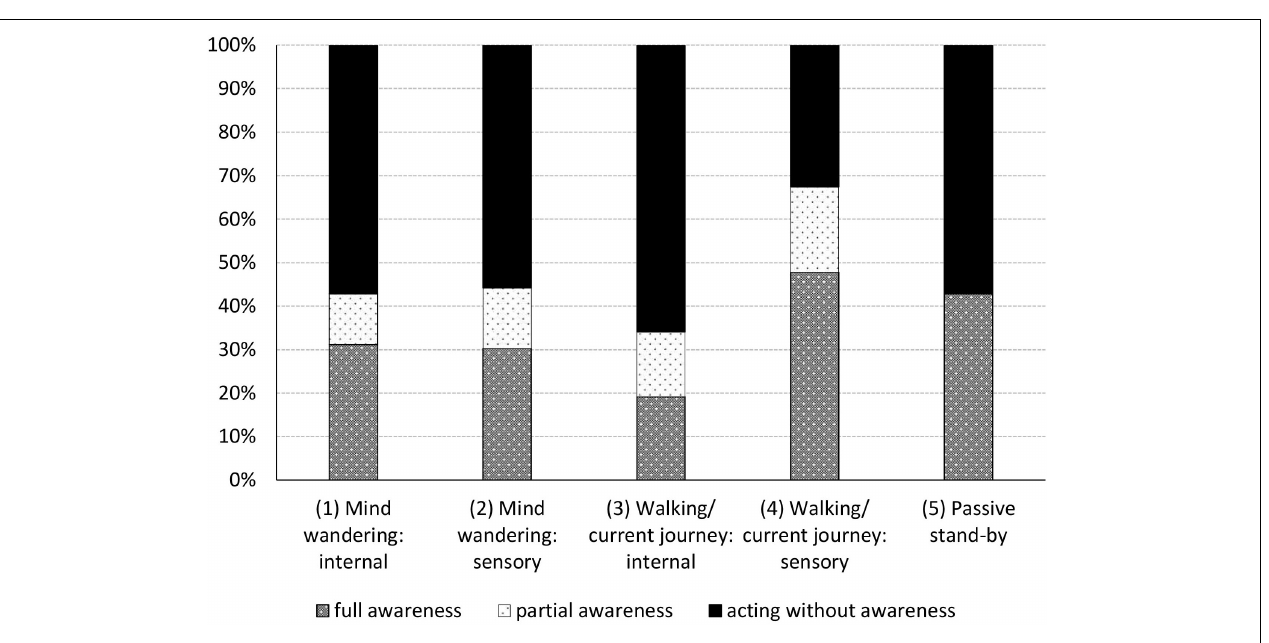
FIGURE 5 | Distribution of participants’ level of awareness for the signboard for each of the five categories of pedestrians’ thoughts (as described in Table 1 ). Pedestrians’ thoughts differed significantly both for those fully aware ( p = 0.043) as well as for the combination of those fully or partially aware of the signboard ( p =